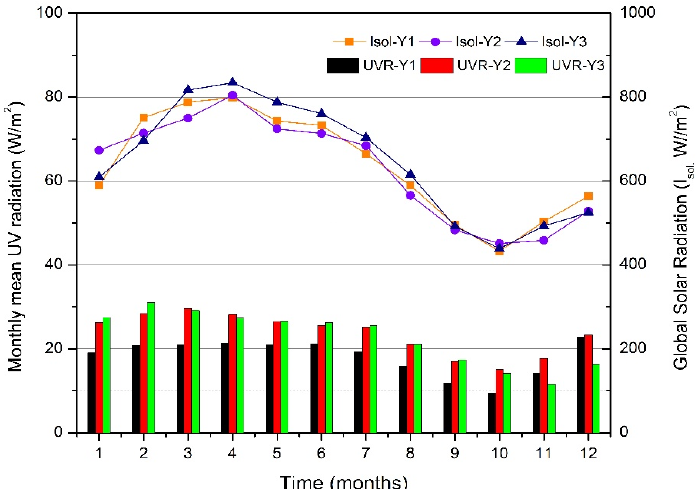
Figure 4. Global solar radiation at site and UV radiation data at Ras Al Khaimah, UAE.